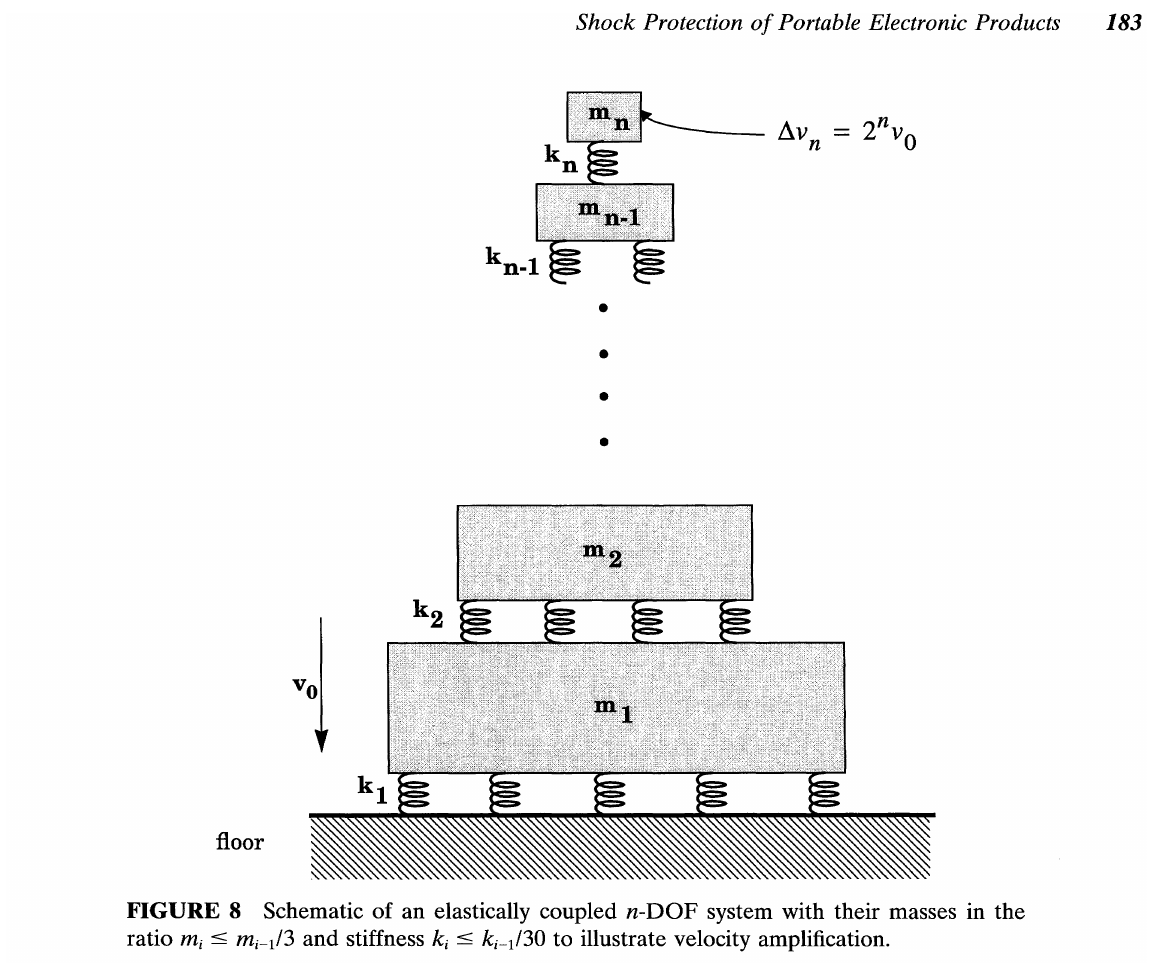
FIGURE 8 Schematic of an elastically coupled n-DOF system with their masses in the ratio mi ::; m H /3 and stiffness k i ::; k i- 1 /30 to illustrate velocity